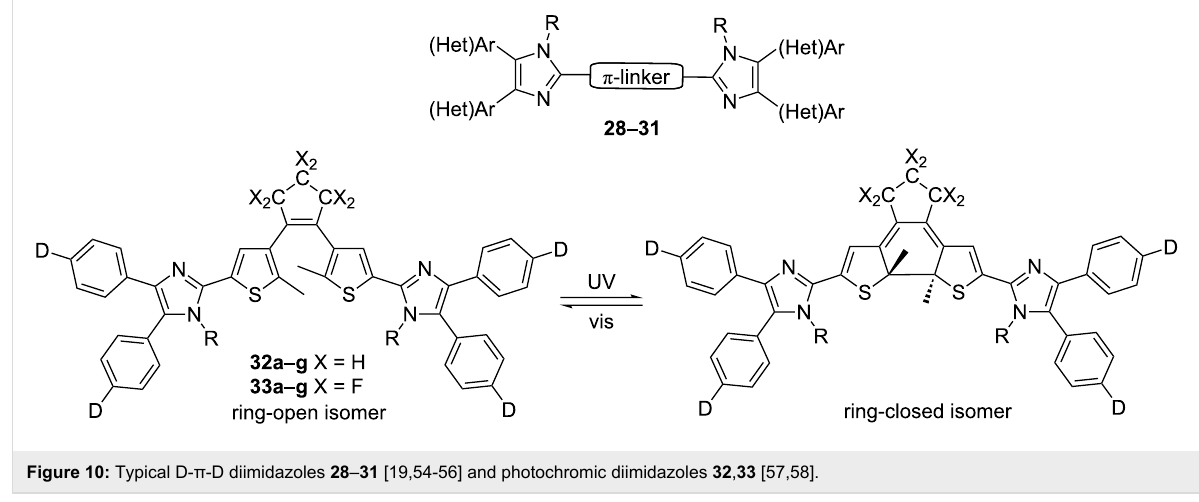
Figure 10: Typical D- π -D diimidazoles 28 – 31 [19,54-56] and photochromic diimidazoles 32 , 33 [57,58].